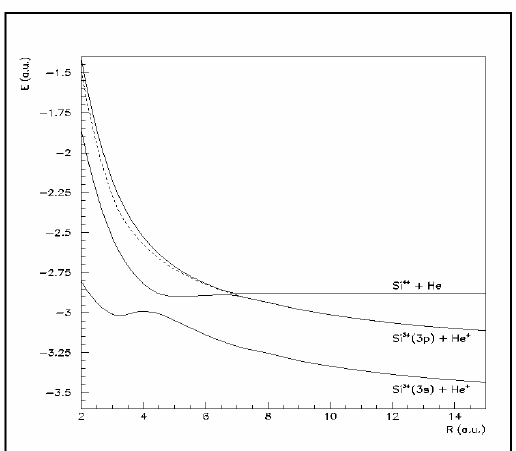
Fig. 7 : Adiabatic potential energy curves for the 1 Σ + (full lines) and 1 Π (dotted line) of Si 4+ +He with previous configuration interaction calculations using the CIPSI algorithm [25] and other ab-initio calculations, using the spin-coupled valence bond method (SCVB) [26,44] or the configuration interac- tion MRD-CI method [27].